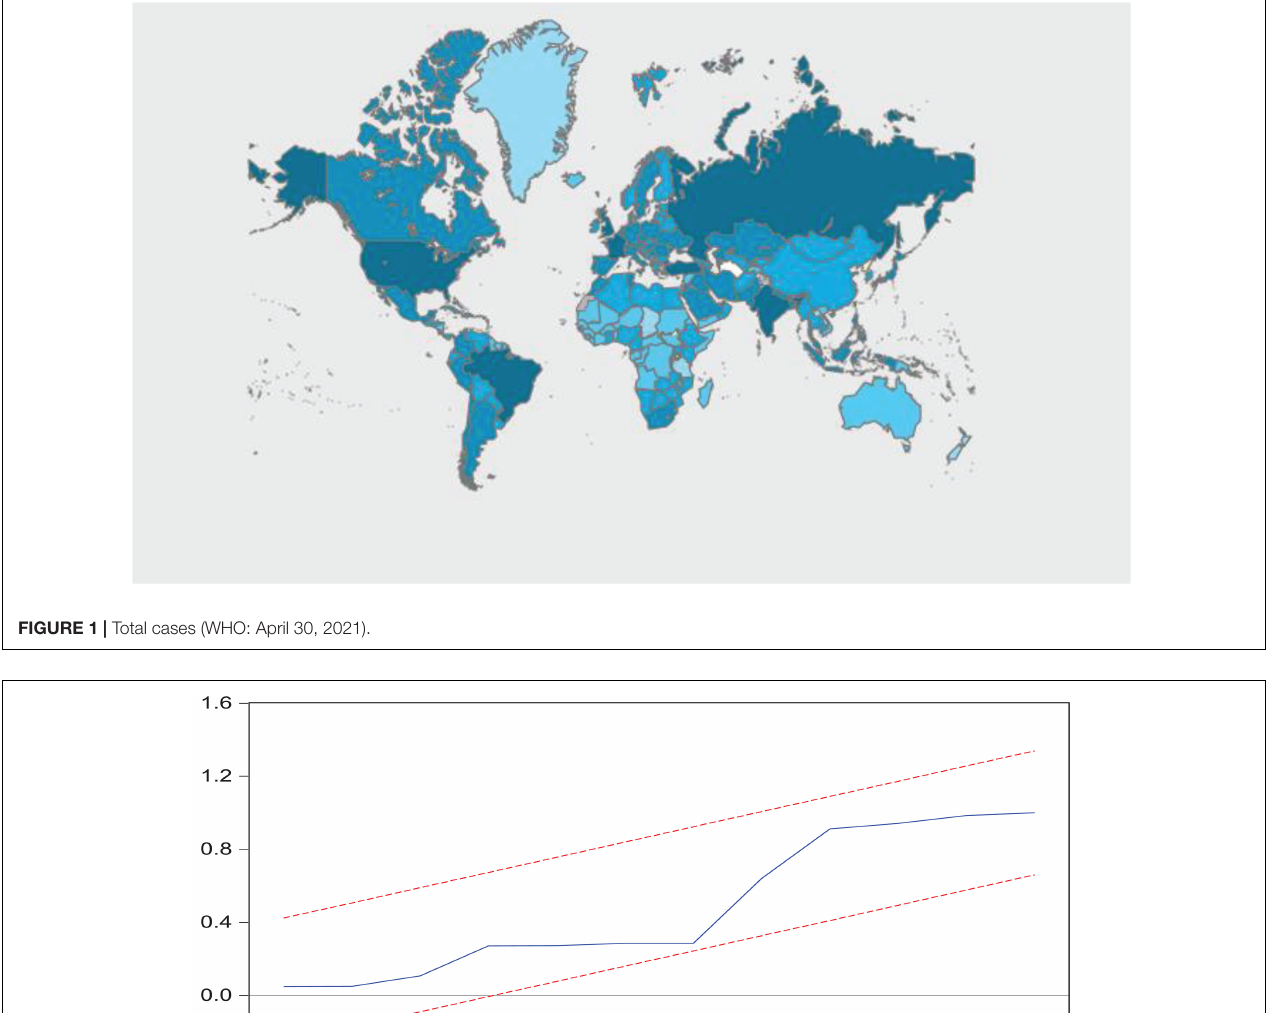
FIGURE 2 | Cumulative sum of